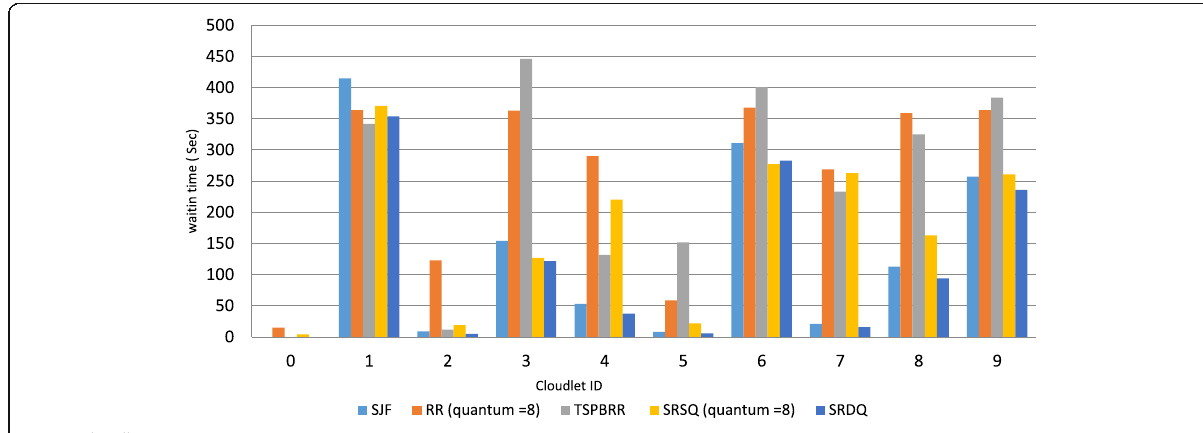
Fig. 4 Cloudlets waiting time on one